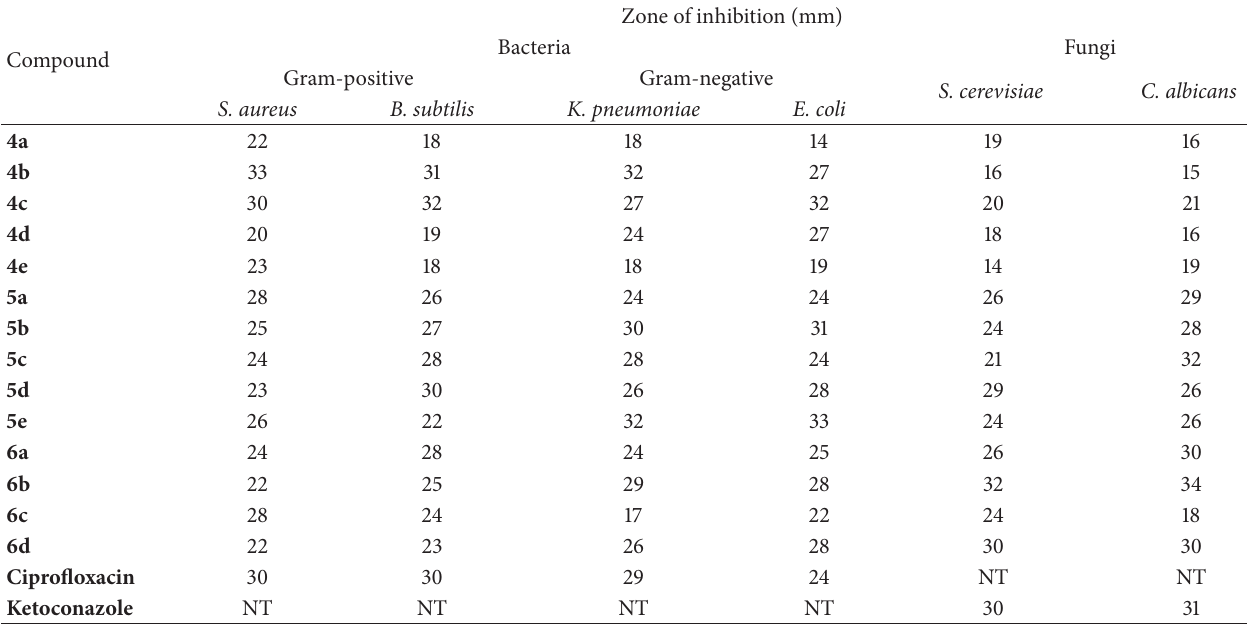
Table 1: Antimicrobial activity expressed as inhibition diameter zones in millimeters (mm) of chemical compounds against the pathological strains based on well diffusion assay.